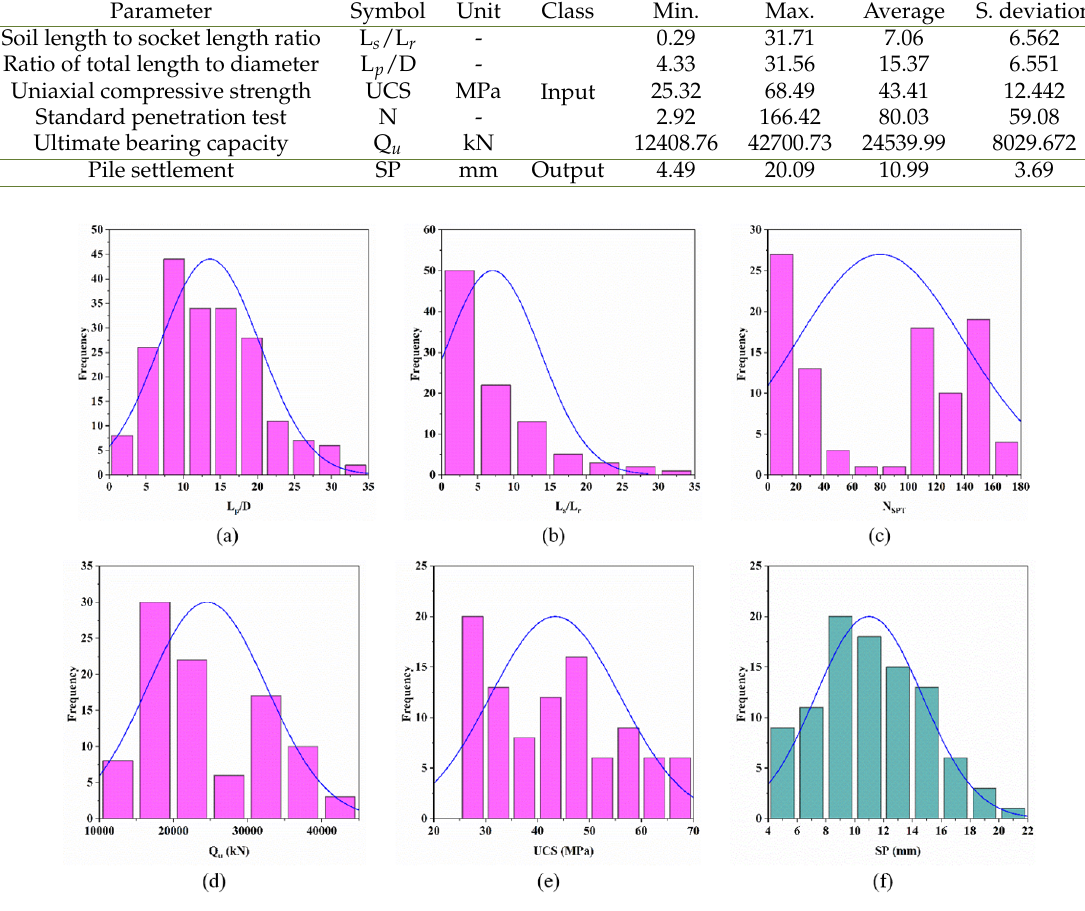
Fig. 3. Histograms of: a) L p /D; b) L s /L r ; c) N SPT ; d) Q u ; e) UCS; f) SP